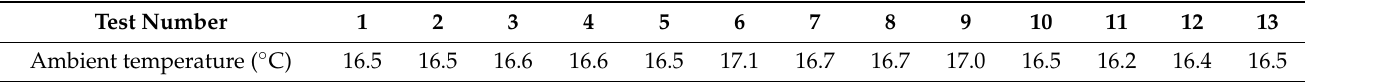
Table 6. Temperature variation in the test ambient.